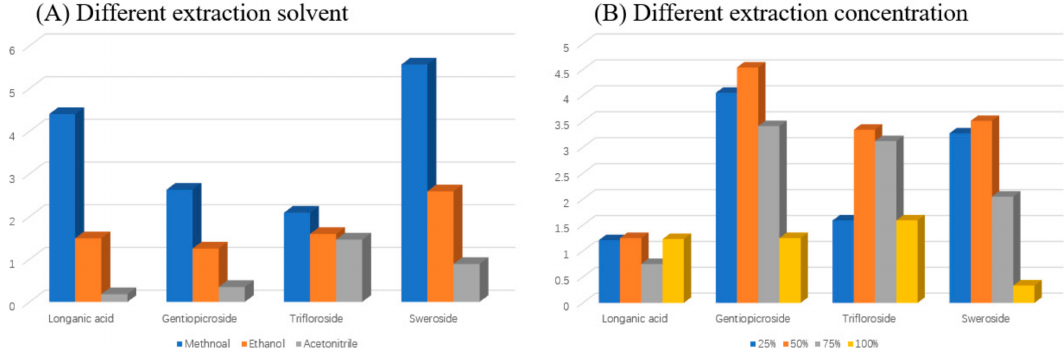
Figure 3. Optimization of sample extraction conditions: ( A ) Di ff erent extraction solvent, ( B ) Di ff erent methanol ratio.